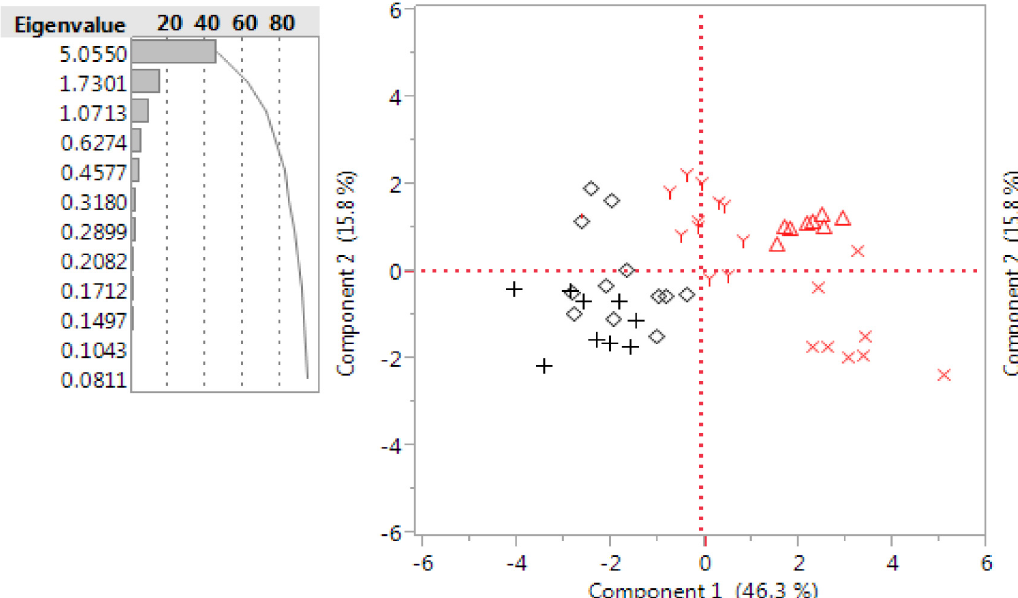
Fig 4. Two main principal components explain 62.1% of the total variation among RSCU indices. The principal component analysis was conducted using RSCU values corresponding to 59 codons of all eukaryotic and viral species used in this study. Based on eigenvalues of 5.05 and 1.73 the first principal component one accounts for the 46.3% of the total variance, while the second principal component for the 15.8%. In black are represented the following species: (+) Orthobunyavirus , Ephemerovirus , Orbivirus and Ceratopogonide . ( ^ ) Vesiculovirus , Phlebovirus and Psychodidae . In red are represented the following species: (Y) Flavivirus , Alphavirus and Thogotoviridae . ( Δ ) Vertebrates. (X) Culicidae and Arachnida